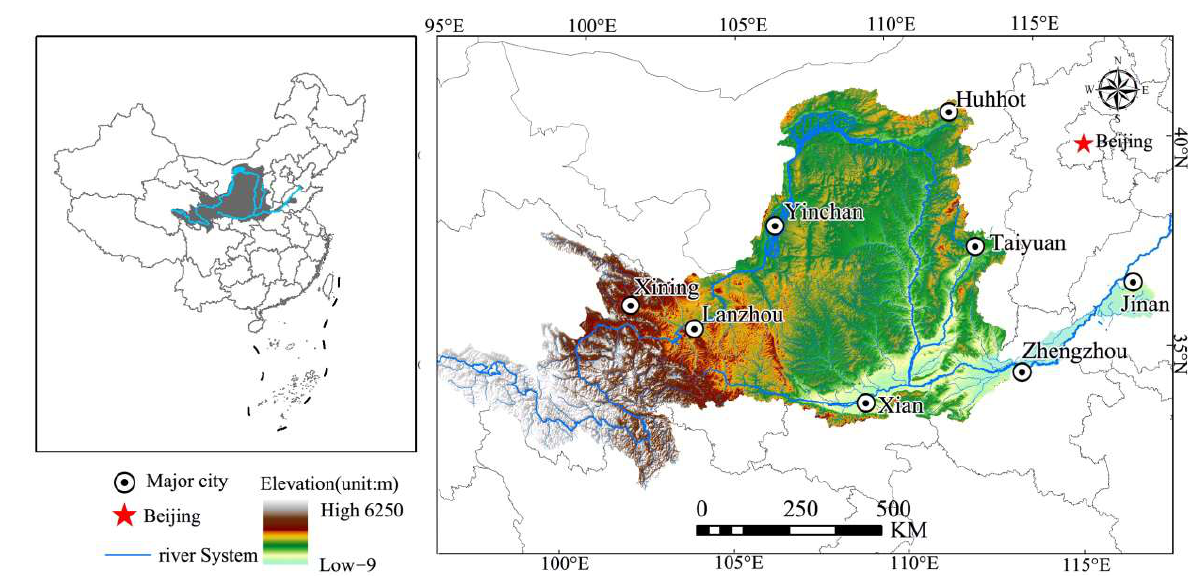
Figure 1. Range of Yellow River basin and distribution of river system.